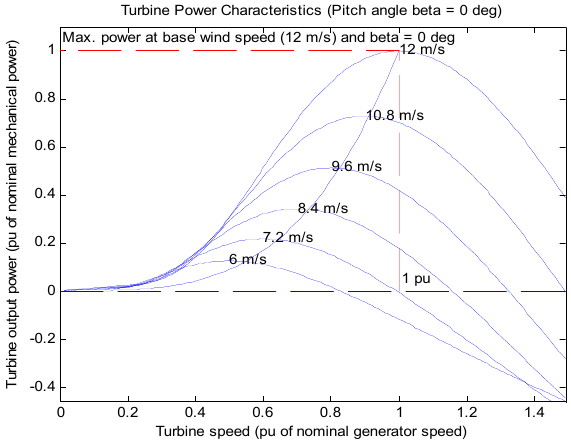
Figure 5. Wind turbine characteristics and power-speed